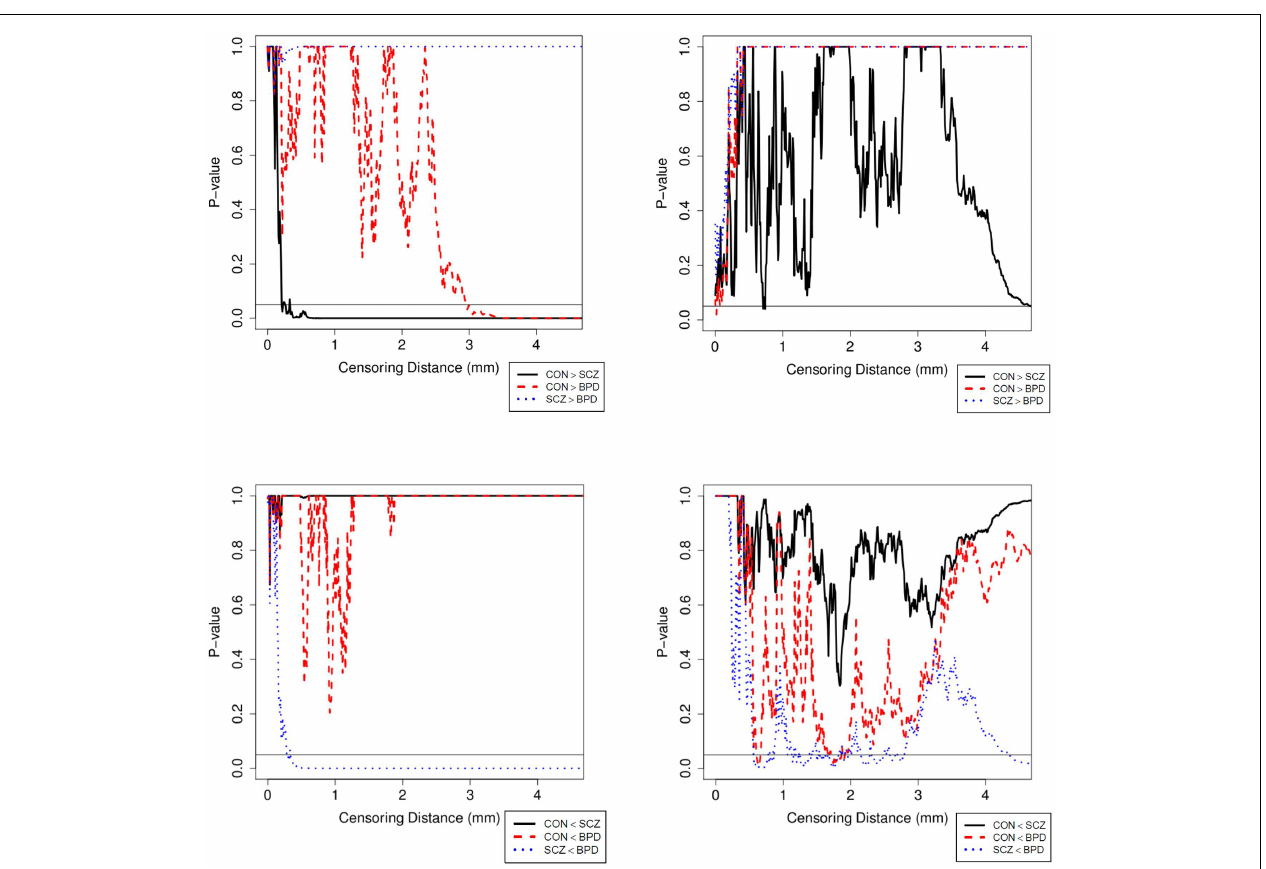
FIGURE 3 | Plot of p -values for the MWU test between diagnostic groups in the LPT (left column) and RPT (right column) . p -Values are adjusted with Holm’s correction for multiple comparisons between the diagnostic groups.The abbreviations are as in Table 1